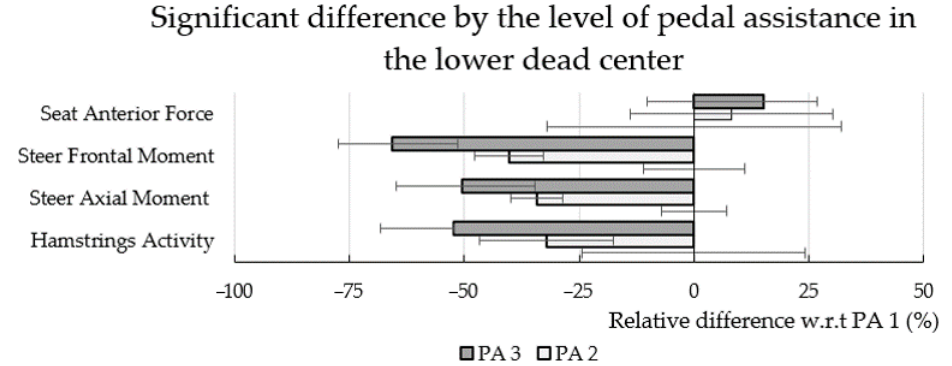
Figure 9. Significant differences based on the level of PA for the lower dead center.